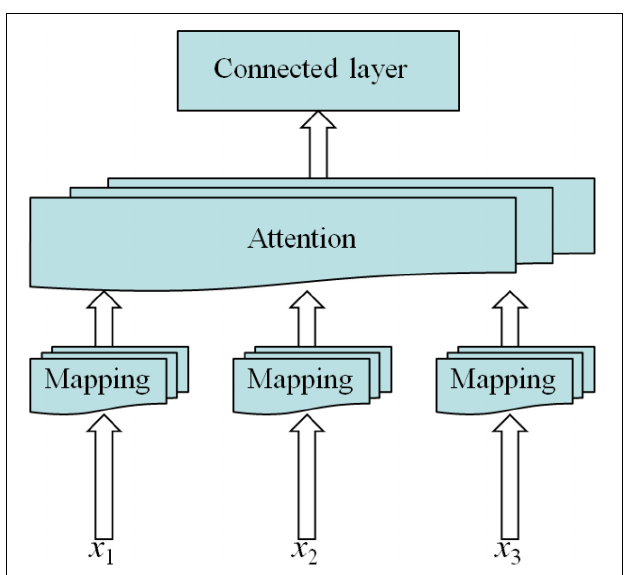
FIGURE 6 | Multi-head attention